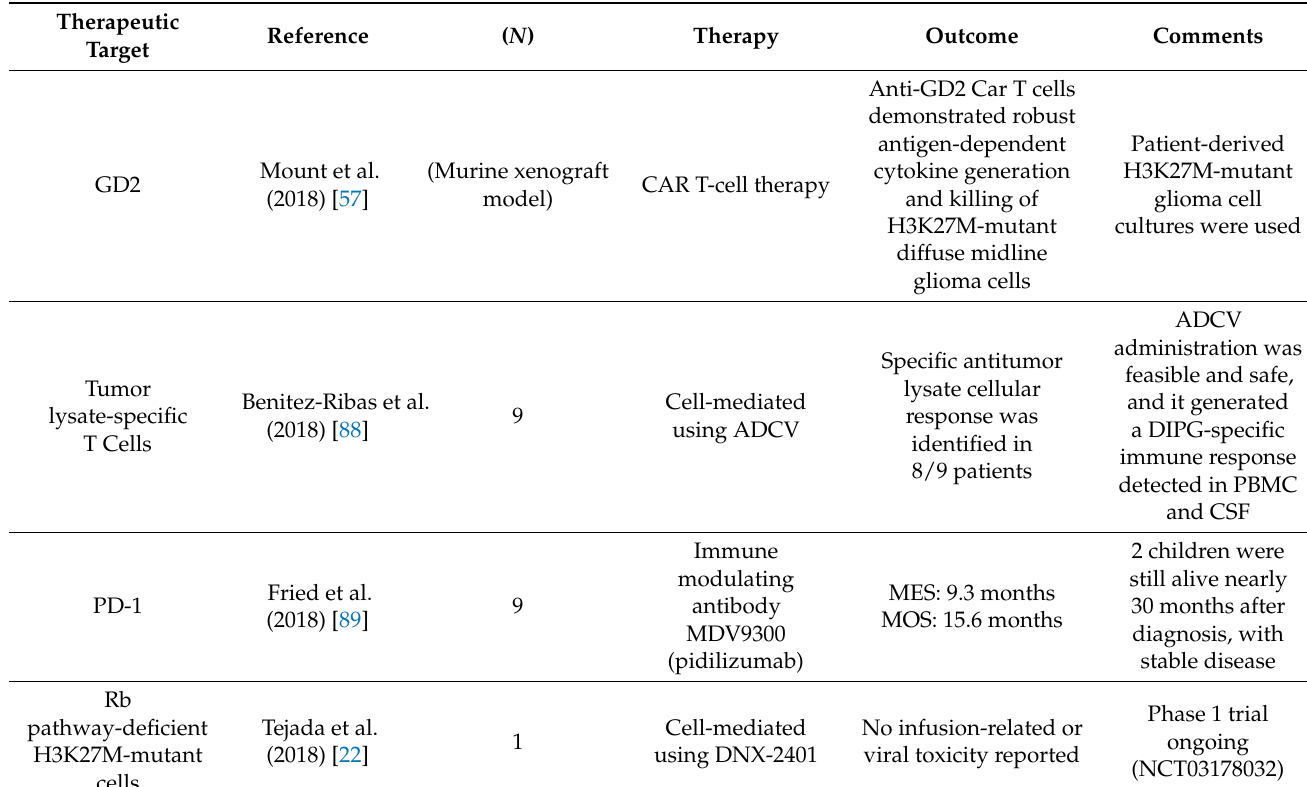
Table 3. Immunotherapy for H3K27M-mutant diffuse midline glioma. Recent immunotherapy studies and trials for the treatment of H3K27M-mutant diffuse midline glioma.